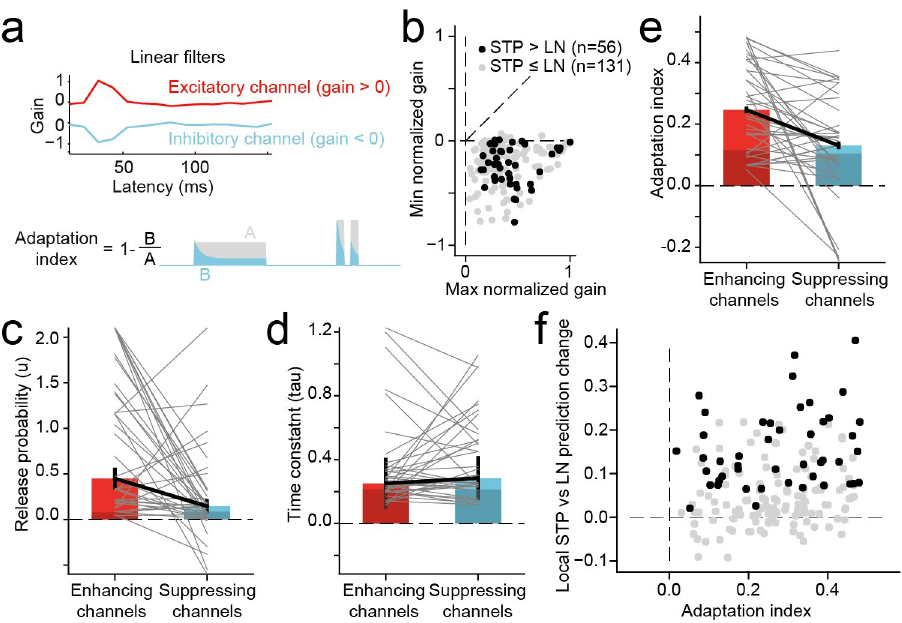
Fig 6. A. In the local STP model, each reweighted spectral channel passed through a nonlinear filter, mimicking synaptic STP, a nonlinear transformation, prior to the linear temporal filter stage. An index of adaptation strength for each model synapse was computed as one minus the fraction change in the amplitude of a test signal after passing through the adapting synapse. An index value > 0 indicated synaptic depression, and a value < 0 indicated facilitation. B. Overall gain for each channel of the linear filter in the STP model was computed as the sum of the filter across time lags. Scatter plot compares gain for the channel with largest magnitude, which was always positive (horizontal axis), and for the channel with smallest magnitude, which was either positive or negative (vertical axis). The vast majority of model fits contained at least one excitatory (positive) channel and one inhibitory (negative) channel (n = 175/187). Units in which the local STP model generated a significant improvement in prediction power are colored black (n = 56, p < 0.05, jackknife t -test). C. Comparison of release probability parameter fit values for STP filters in excitatory versus inhibitory channels ( n = 56 STP models with significant improvement in prediction power). Gray lines connect values for a single model. Average values were significantly greater for excitatory versus inhibitory synapses for release probability (mean 0.45 vs. 0.15, p = 1.4 x 10 − 6 , sign test). D. Comparison of STP recovery time constant, plotted as in D, shows no difference between excitatory and inhibitory channels (mean 0.063 vs. 0.081 s, p > 0.5, sign test). E. Comparison of adaptation index shows a significant difference between excitatory and inhibitory channels (mean 0.25 vs. 0.13, p = 2.8 x 10 − 4 sign test). F. Scatter plot compares average adaptation index for each local STP model against the change in prediction correlation between the LN and local STP model. There is a positive correlation between STP effects and changes in prediction accuracy ( r = 0.17, p = 0.023, n = 187, Wald Test). Neurons with significant changes in prediction accuracy are plotted as in